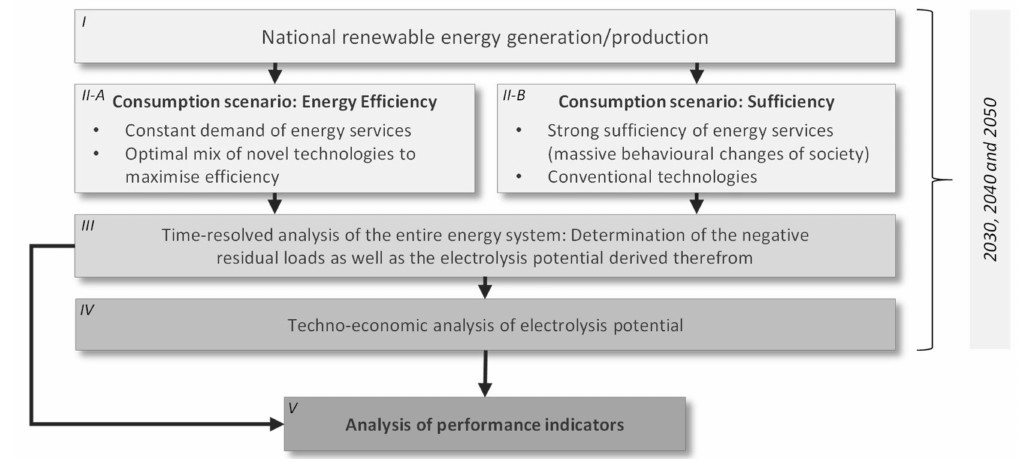
Figure 1. Flow chart of the methodology.